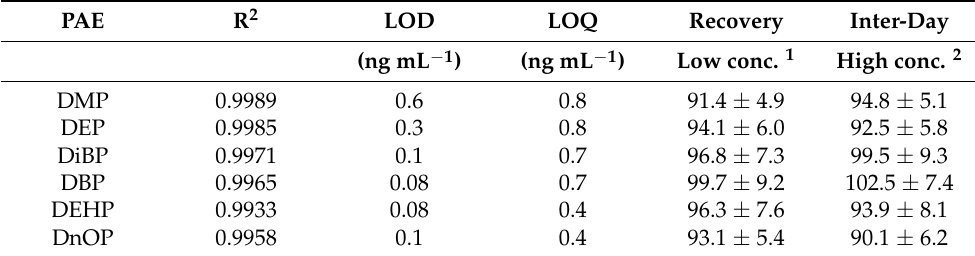
Table 4. Analytical parameters studied in the range 1–500 ng mL − 1 by means of GC-IT/MS: cor- relation coefficients (R 2 ), limit of detection (LOD), limit of quantification (LOQ), and percentage recoveries of spiked samples at two different concentrations for each PAE investigated in this study.